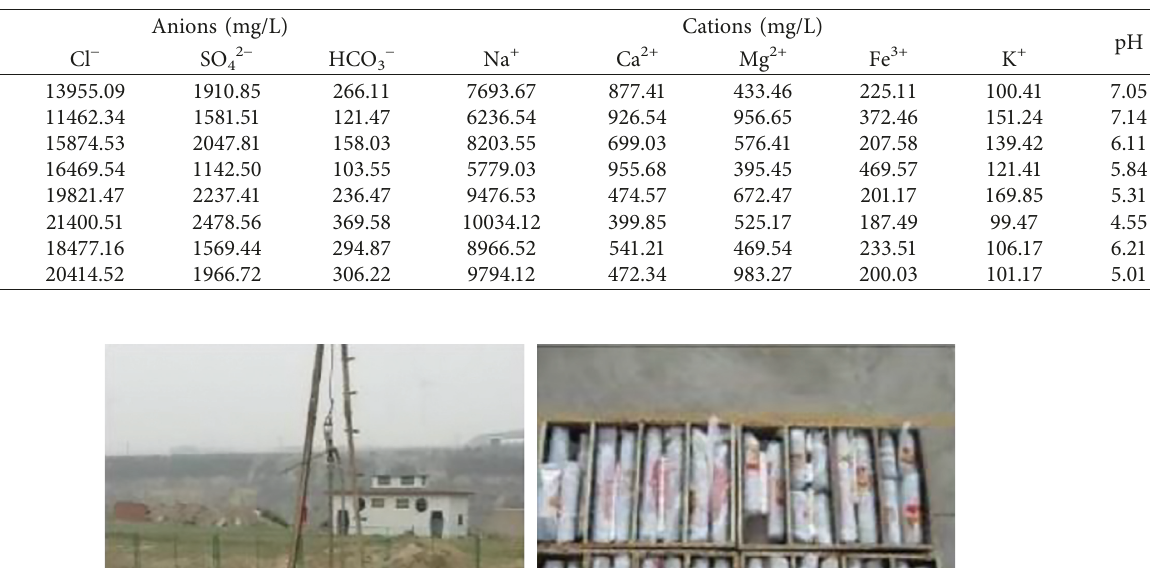
Table 2: The analysis of solution pH in groundwater.